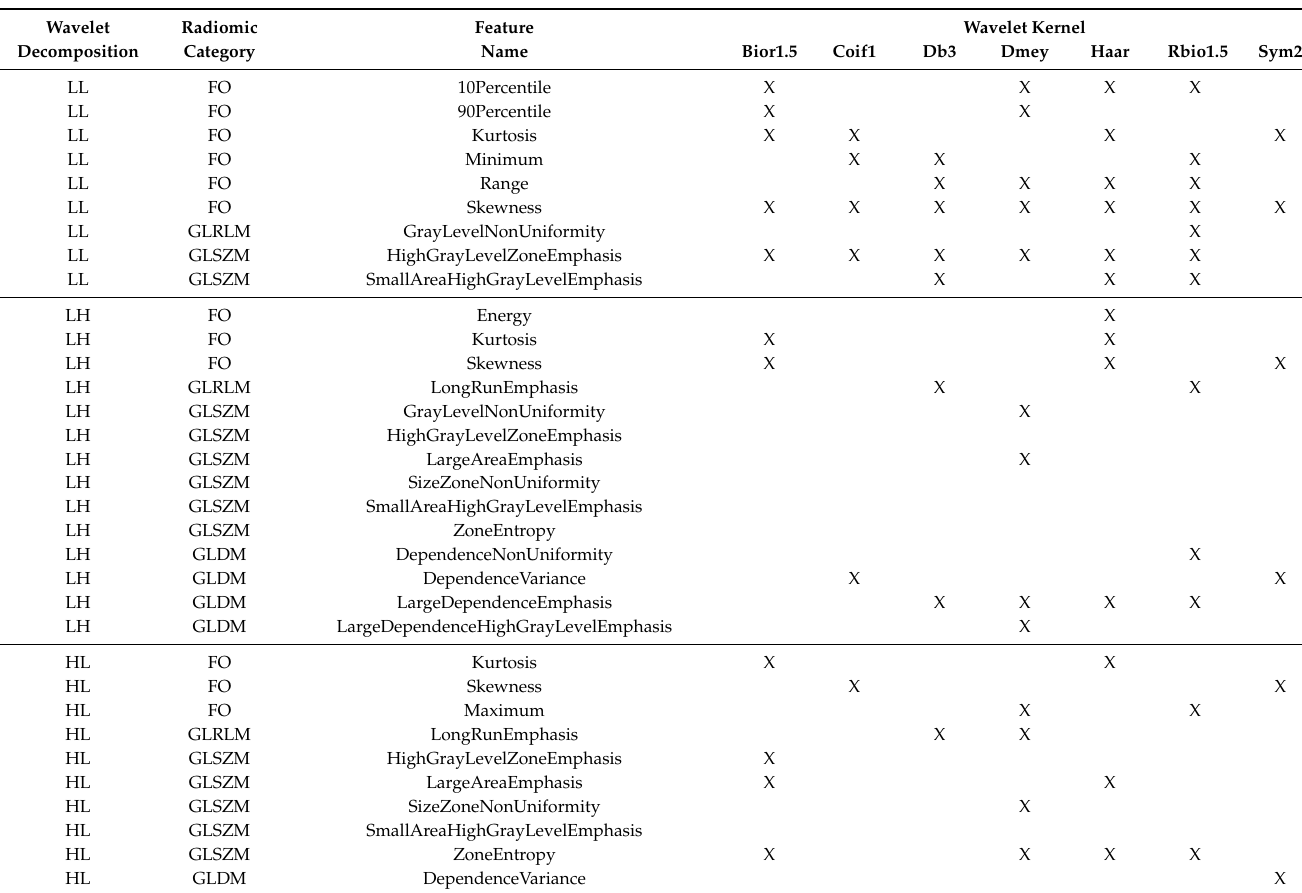
Table A2. Complete list of radiomic features selected via SFS, considering SVM model for each wavelet kernel